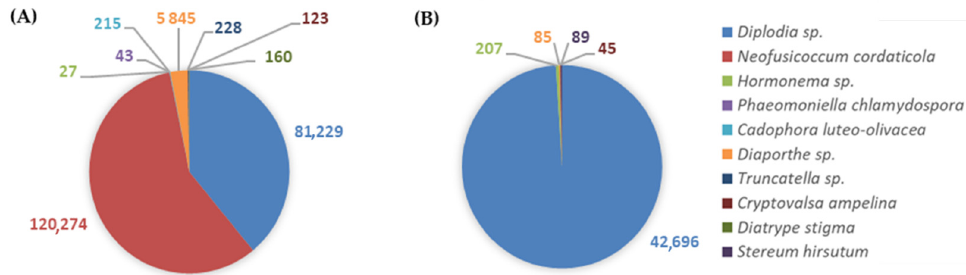
Figure 10. Distribution of GTDs-associated fungi illustrating the respective number of reads identified in: ( A ) cv. ‘Alicante Bouschet’, the most susceptible to GTDs, and ( B ) cv. ‘Trincadeira’, the least susceptible to GTDs.